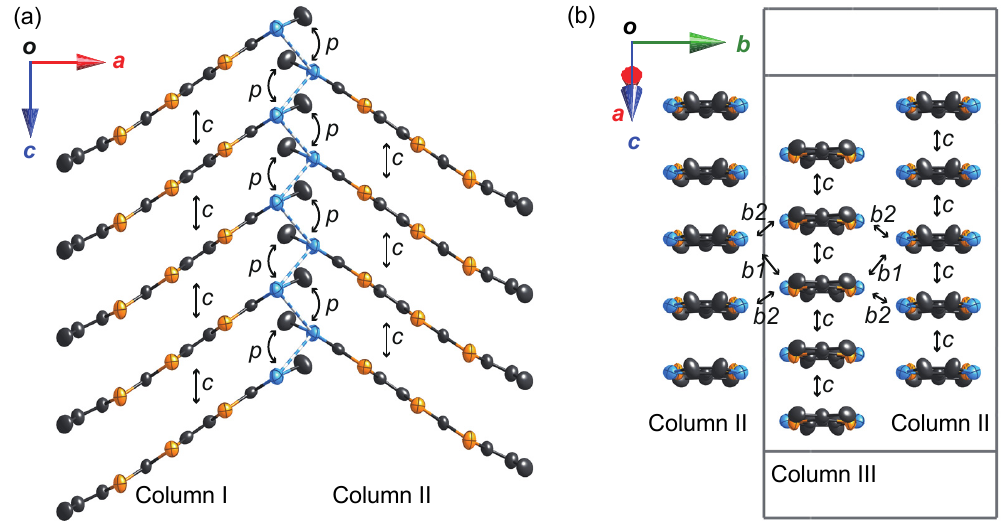
axis and ( b ) columns II and III viewed along the molecular long axis. The calculated overlap are omitted for clarity.